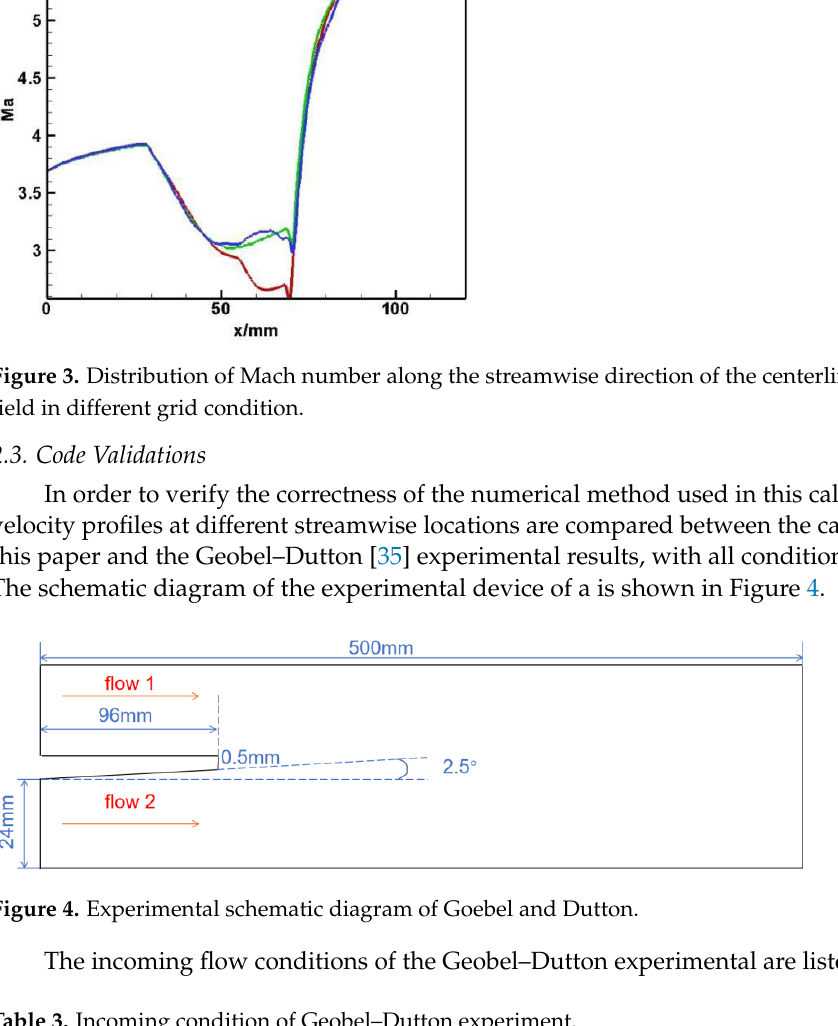
Figure 2. Computational mesh distribution.